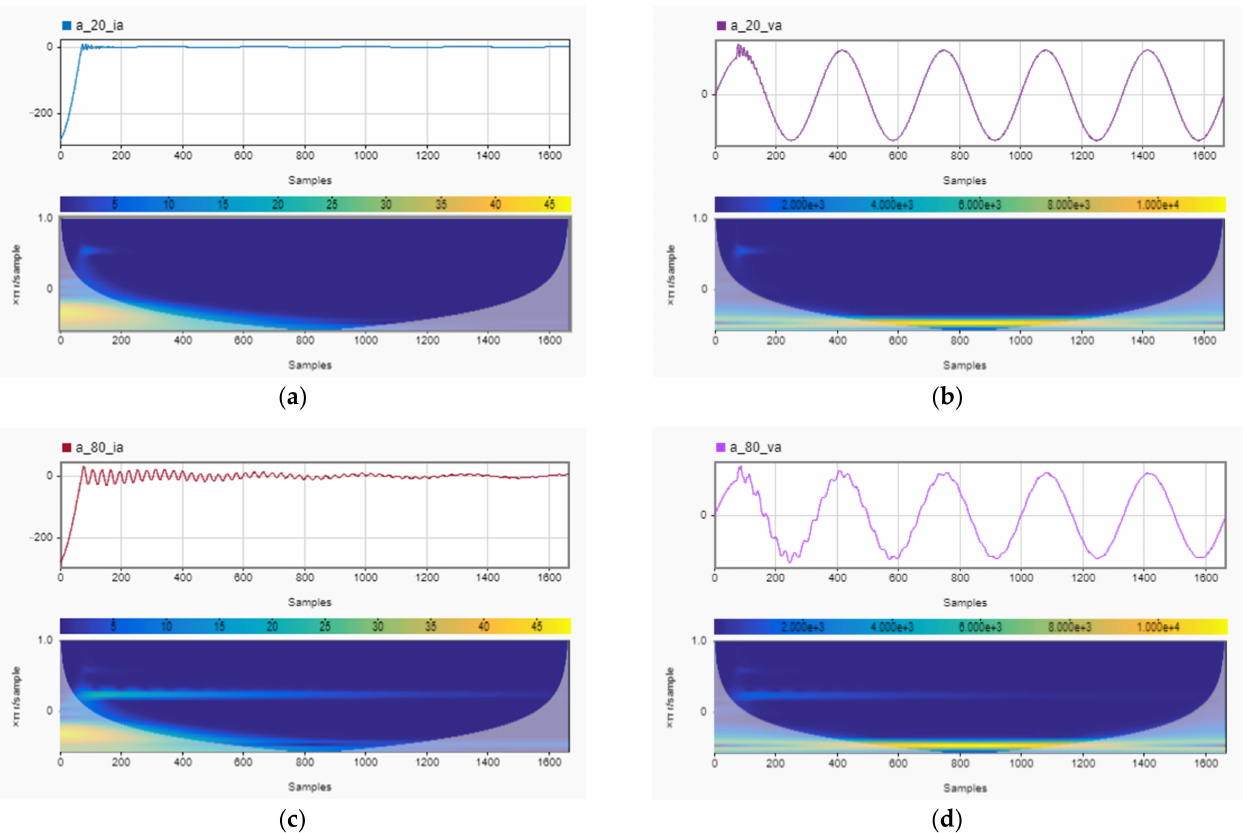
Figure 9. Phase A fault signal scalogram: ( a ) 20 km fault current, ( b ) 20 km fault voltage, ( c ) 80 km fault current, and ( d ) 80 km fault